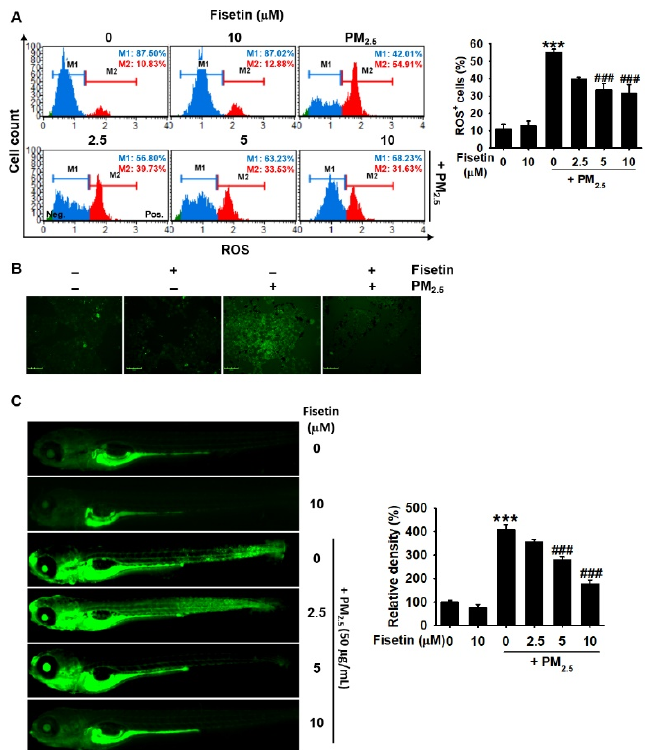
Figure 3. Fisetin inhibits the PM 2.5 -induced production of ROS. HaCaT keratinocytes were treated with fisetin (0–10 μ M) for 2 h and subsequently exposed to 100 μ g/mL PM 2.5 for 24 h. ( A ) The cells were stained with a Muse Oxidative Stress Assay Kit and the population of ROS + cells was subse- quently measured. ( B ) In a parallel experiment, the cells were treated with 10 μ M fisetin in the pres- ence or absence of 100 μ g/mL PM 2.5 for 24 h. The cells were incubated with 10 μ M DCFDA for 10 min and the images of the cells were captured using a CELENA S Digital Imaging System. Scale bar = 100 μ m. ( C ) Zebrafish larvae at 3 days post-fertilization were pretreated with fisetin (0–400 μ M) for 2 h and exposed to 50 μ g/mL PM 2.5 for 24 h. The larvae were incubated with 20 μ M DCFDA for 30 min and visualized using a CELENA S Digital Imaging System. The fluorescence intensities were calculated using the ImageJ software and are expressed. *** p < 0.001 vs. untreated larvae and ### p < 0.001 vs. PM 2.5 -treated larvae.